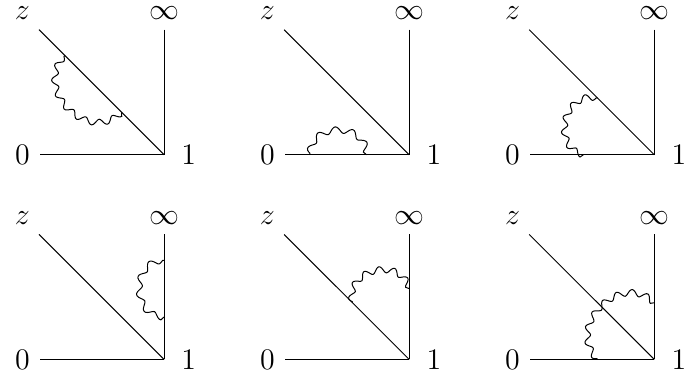
Figure 4 . Contributions to the four point blocks from the networks of open Wilson lines at the 1 =c order. The two bottom left diagrams are of the type as in the right diagram of (cid:12)gure 3 with z 0 = 1. Therefore we should be careful to choose the vertex when a spin 3 = 2 current is exchanged.